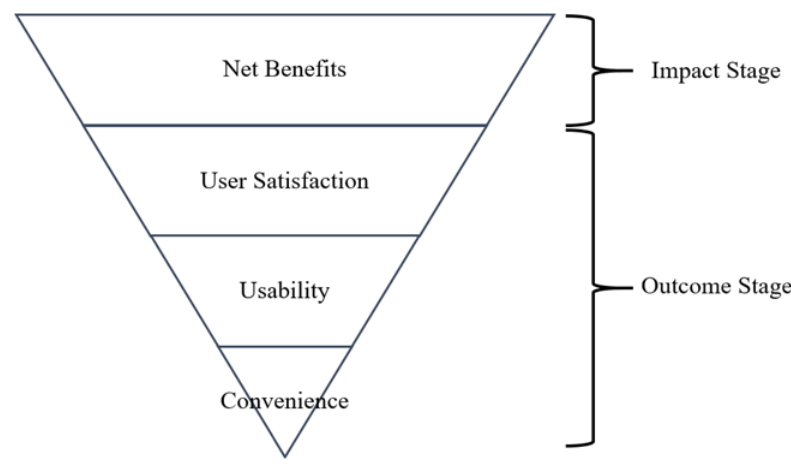
Figure 8 Different Concern of